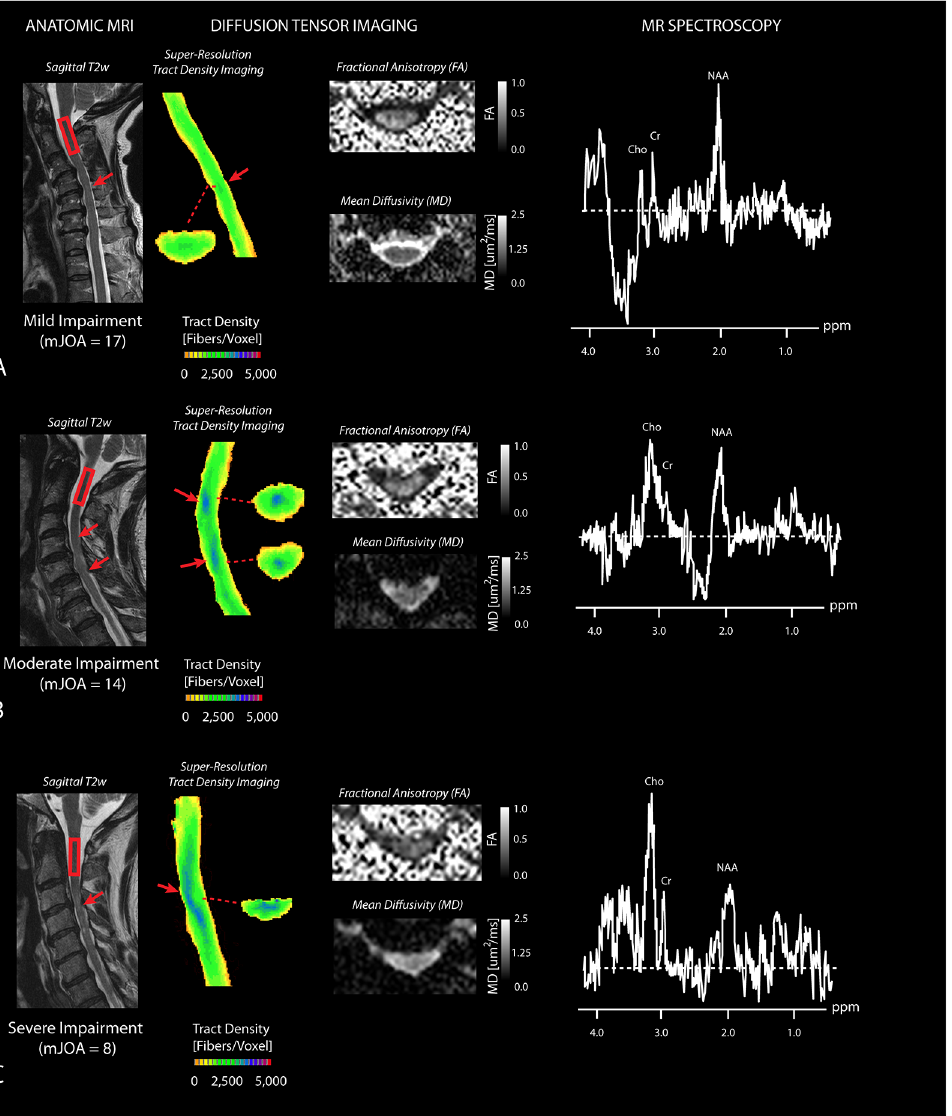
Fig 1. Anatomic, Diffusion, and Spectroscopic MR Measurements in Cervical Spondylosis. A) A patient with mild impairment (mJOA = 17) showing slightly elevated fiber tract density, relatively normal FA and MD, and a dominant NAA peak. B) A patient with moderate impairment (mJOA = 14) showing focally high fiber tract density, lower FA and higher MD, along with emergence of a Cho metabolites. C) A patient with severe impairment (mJOA = 8) showing elevated T2 hyperintensity on T2-weighted images, high fiber tract density indicative of compressed fibers extending rostral-caudal from the site of compression, lower FA and higher MD at the site of greatest stenosis, and dominant Cho peak in the MR spectra. Red box at C2 indicates the voxel used for MR spectroscopic measurement. Red arrow shows area of